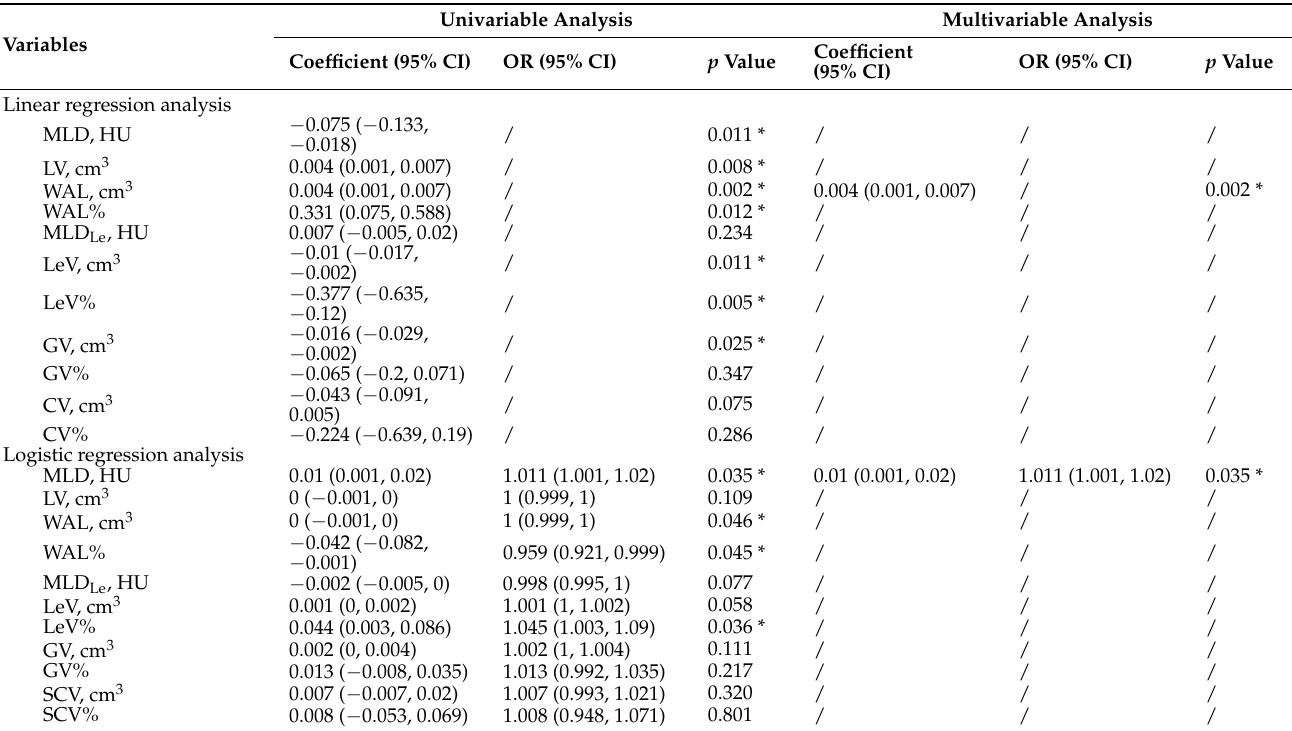
Table 4. Regression analysis of predictors from total lung tissue quantitative CT indexes of pulmonary diffusion function in convalescent COVID-19 patients.